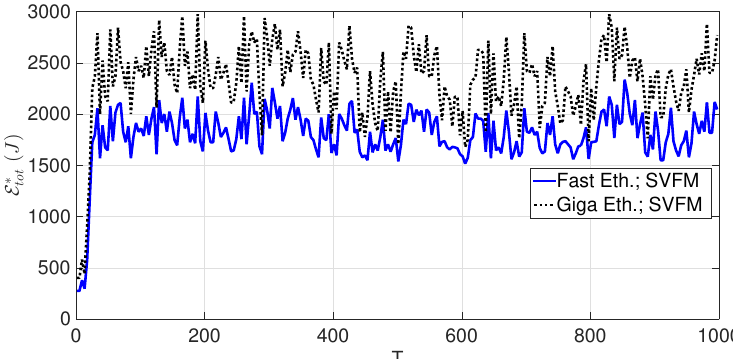
Figure 5. Fast/Giga Ethernet LANs on the energy consumption of SVF for T =